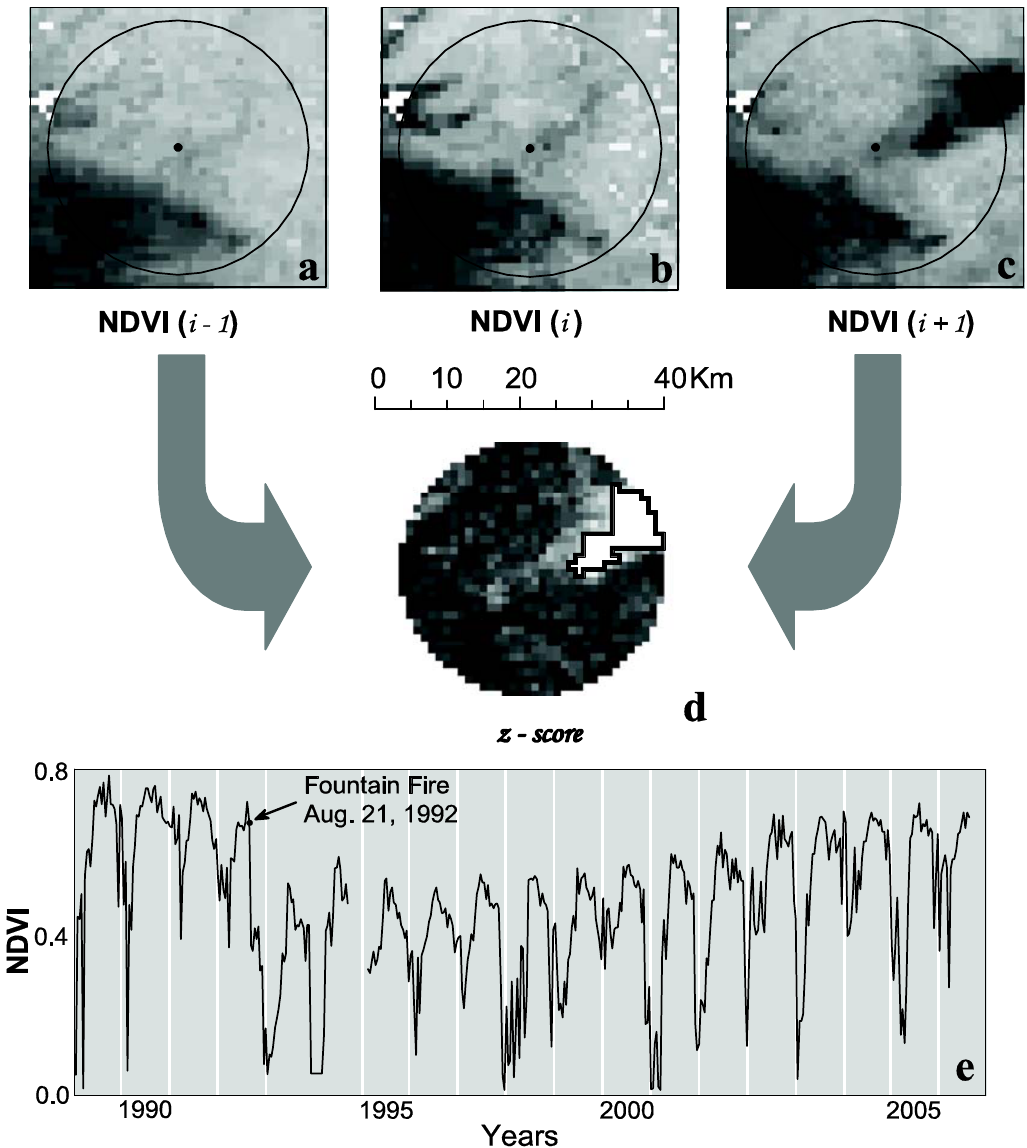
Figure 1. Work flow for the selection of fires meeting the minimum burned area criteria of 10 km 2 . Fire locations in the DRI database (n = 3,198) were buffered with a circular area twice that of the reported burned area. This example shows the Fountain Fire (August 1992 east of Redding, California). The fire was reported in period i (b) . A z-score was calculated for the difference between periods i − 1 and i + 1 (a, c) relative to the average differences between two periods j − 1 and j + 1 across the time-series. If the z-score of a pixel exceeded the threshold of 1.65, and a contiguous group of six such pixels existed, the fire was included in the analyses, and a polygon establishing the perimeter of the fire was created (d) . The polygon was then used to define an area within which to calculate the average for each period of AVHRR NDVI data from January 1989 to June 2007 (e) . These data were summarized by summing the NDVI values for each post-fire year (26 AVHRR periods) in the record (e) . These summaries were then used in regression equations to establish relationships between post-fire trends and broad-scale environmental